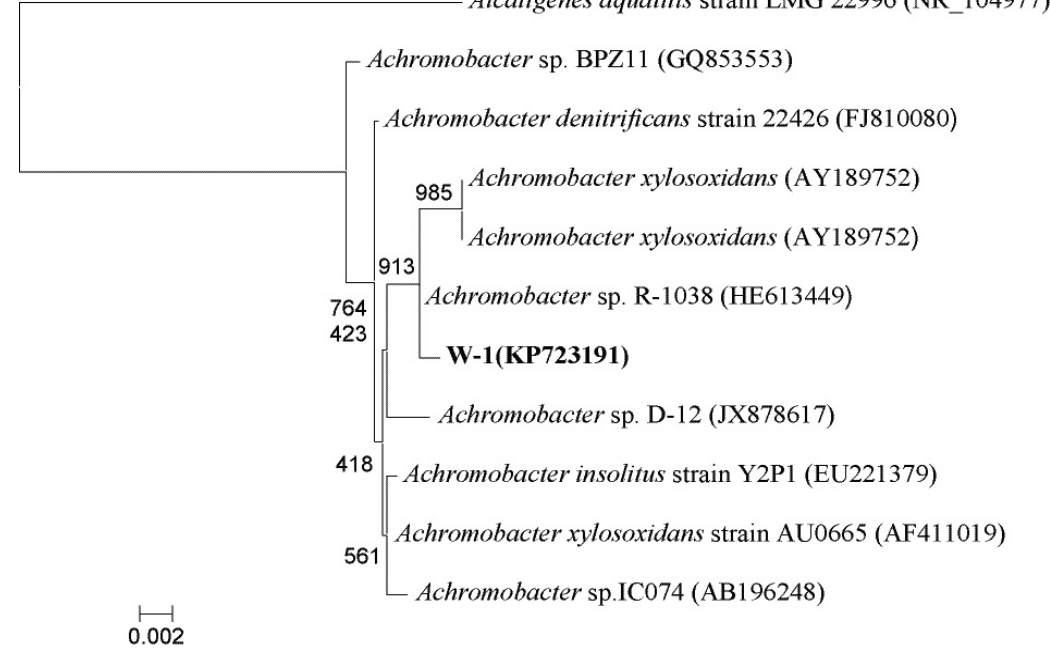
Figure 2. Phylogenetic tree derived from the 16S rRNA gene sequence of strain W-1 and sequences of related species. Distances were calculated using the neighbor-joining method. Numbers at branch points are bootstrap values (based on 1000 samplings). Alcaligenes aquatilis strain LMG 22996T (NR_104977) was used as the out-group. Scale bars represent 0.002 substitutions per site.